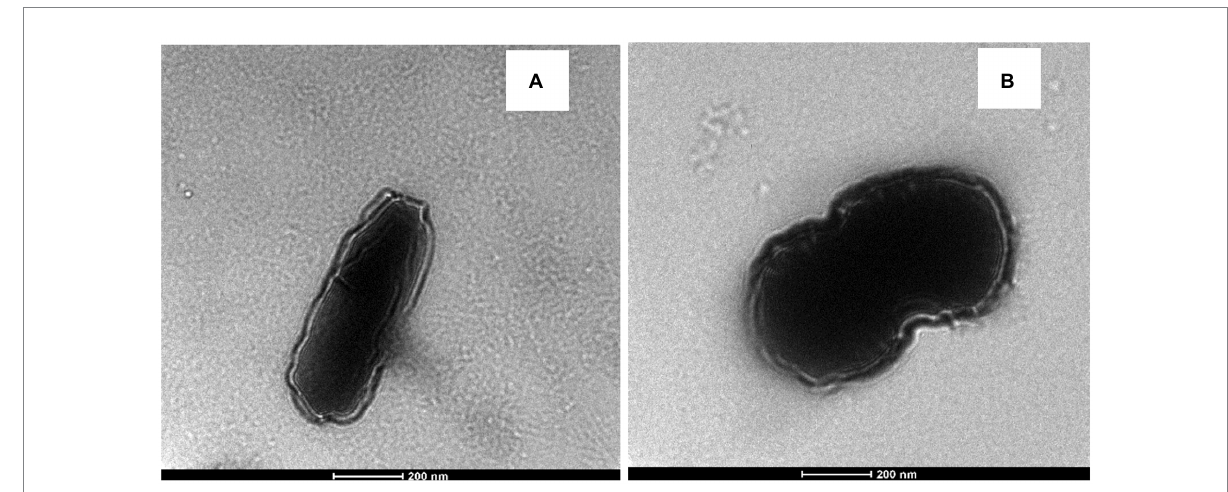
FIGURE 6 TEM of (A) E. durans and (B) E. faecalis showing the shape of the cells and the thickness of the cell walls with exposure to acrylamide.